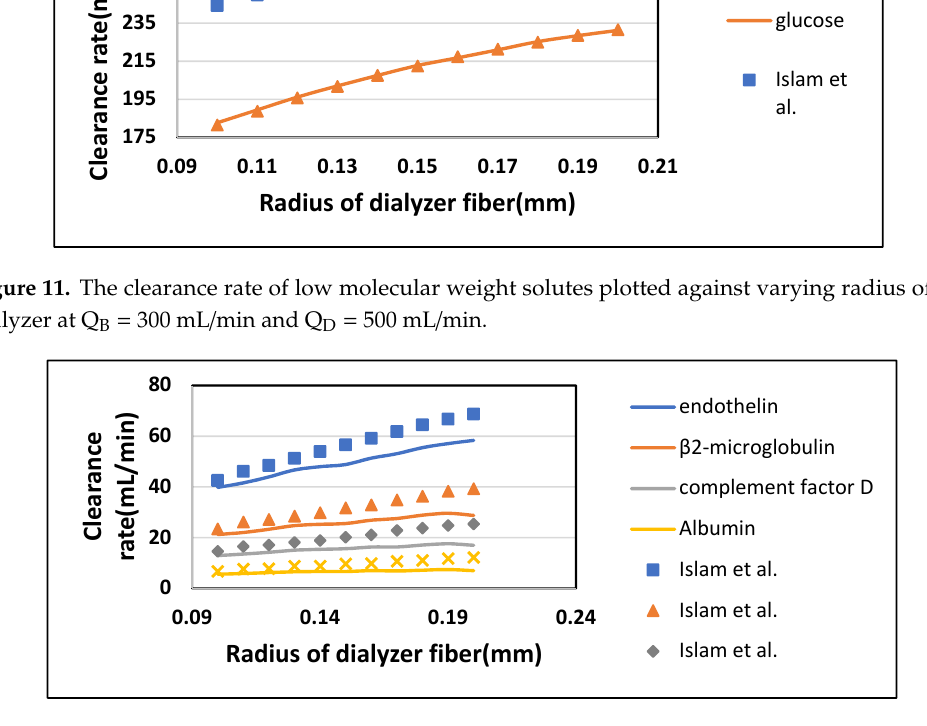
Figure 12. The clearance rate of high molecular weight solutes plotted against varying radius of the dialyzer at Q B =300 mL/min and Q D =500 mL/min.